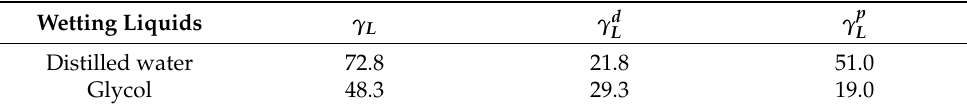
Table 5. Surface tension components of probe liquids (mJ/m 2 ) [24].